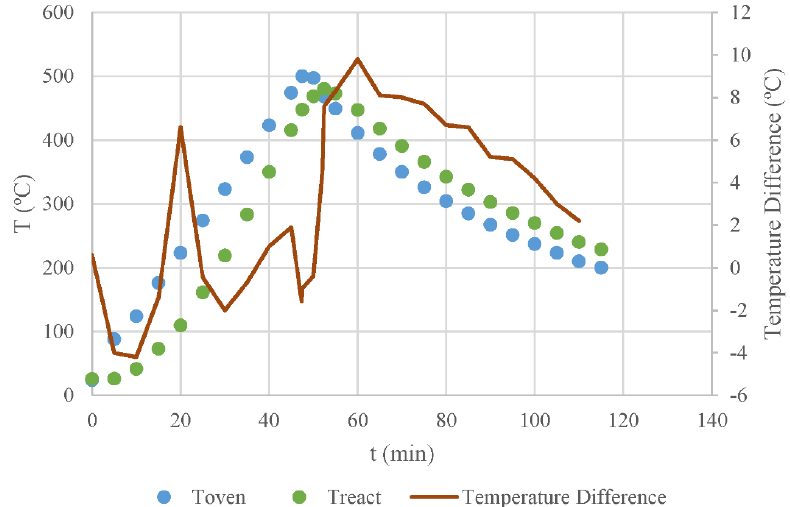
Figure 4. Temperature profile for the non-isothermal reactor containing the cork sample, corre- sponding temperature in the oven, and temperature difference between the reactor containing the sample and the empty reactor for the same temperature